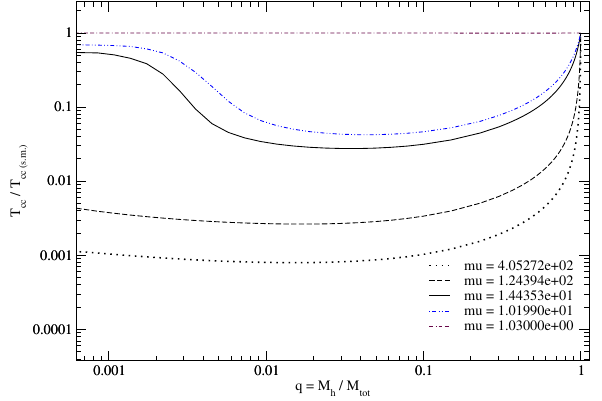
Fig. 26 Core-collapse time for different values of q and